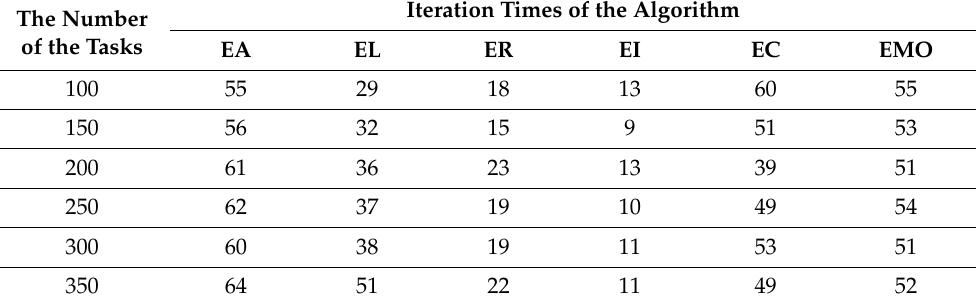
Table 4. The optimal scheduling scheme iterations.